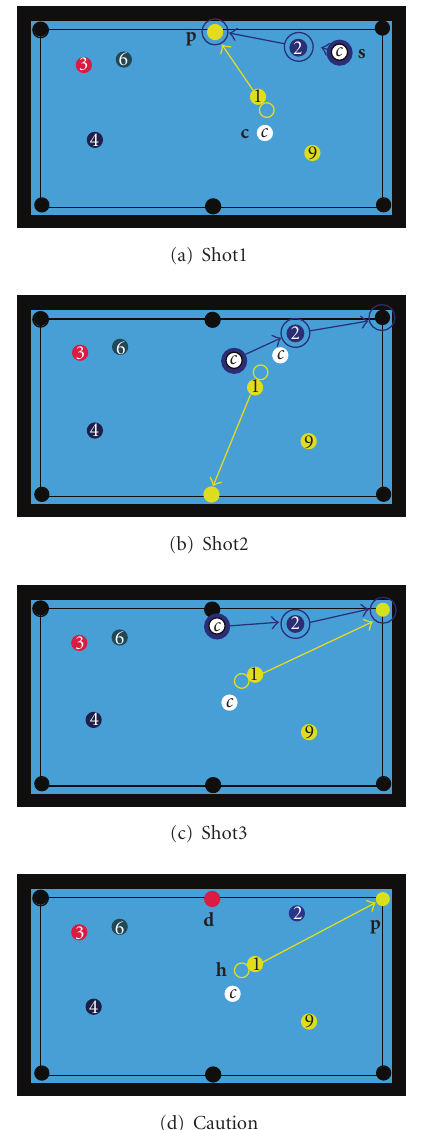
Figure 20: Ball arrangement for free ball. Figure 21: Supporting information of Figure